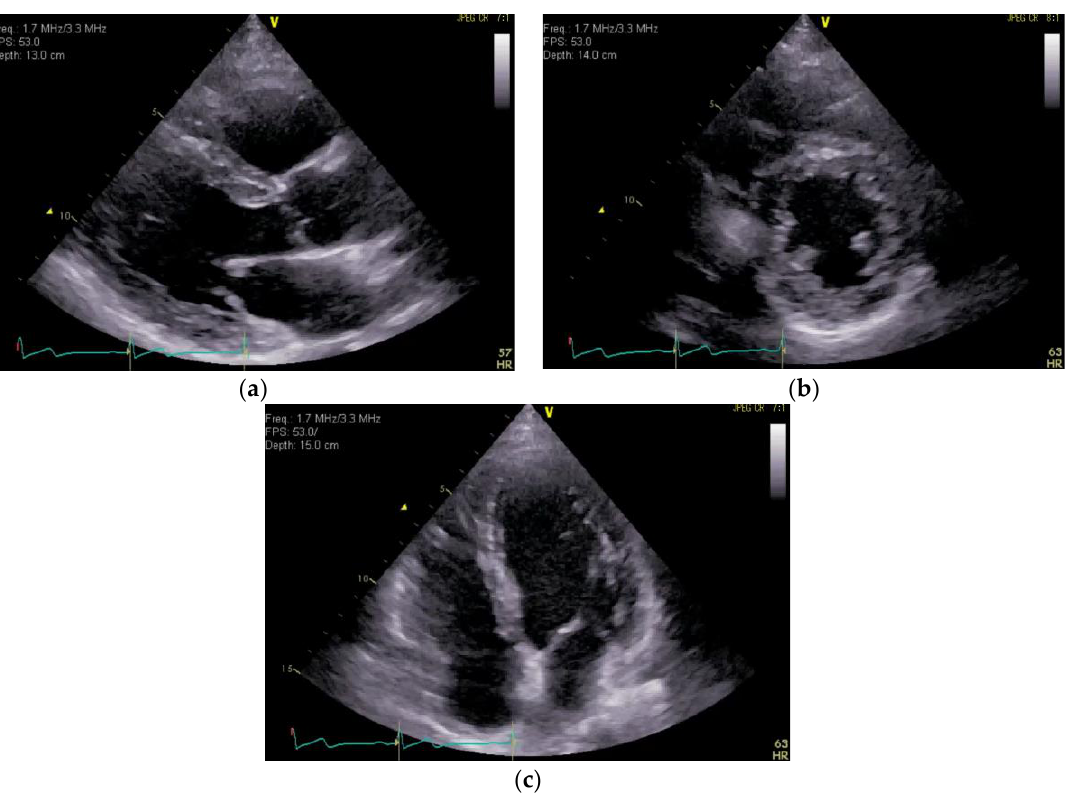
Figure 2. Transthoracic echocardiography. Transthoracic echocardiography showed that both left and right ventricles were of normal size, as seen on the parasternal left border long-axis tomogram ( a ) and parasternal left border short-axis tomogram ( b ), with no evidence of left ventricular compression. In the four-chamber view ( c ), the right ventricle seemed to be slightly enlarged.